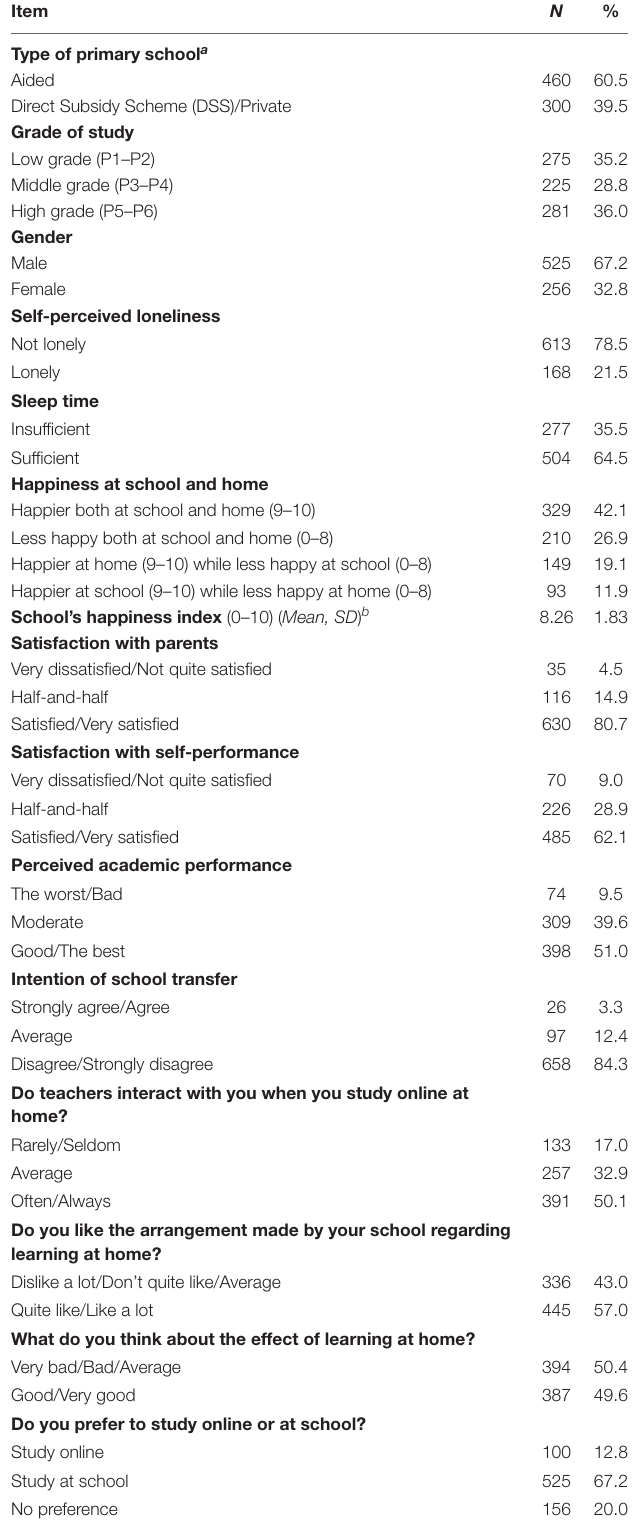
TABLE 1 | Students’ demographic characteristics and responses to the survey items ( N =